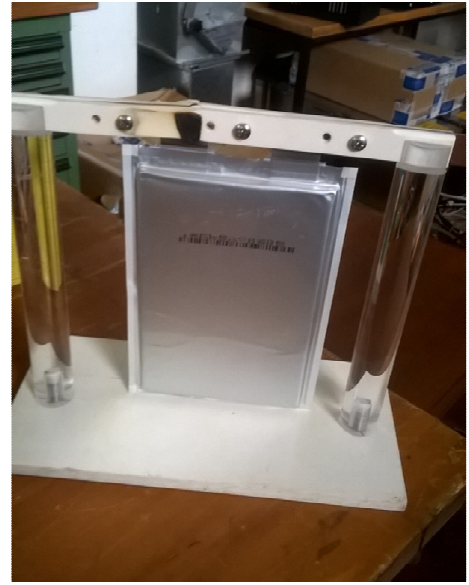
Figure 1. EiG PLB C020 cell.